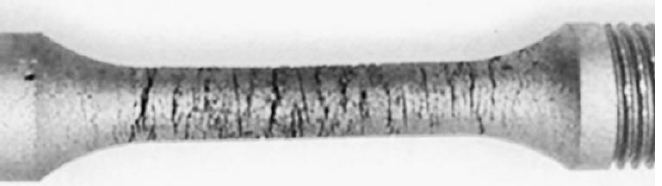
Figure 11. Smooth cylindrical specimen of a diameter of 5 mm after the combined action of tensile stress and hydrogen charging. Scale 1:2.